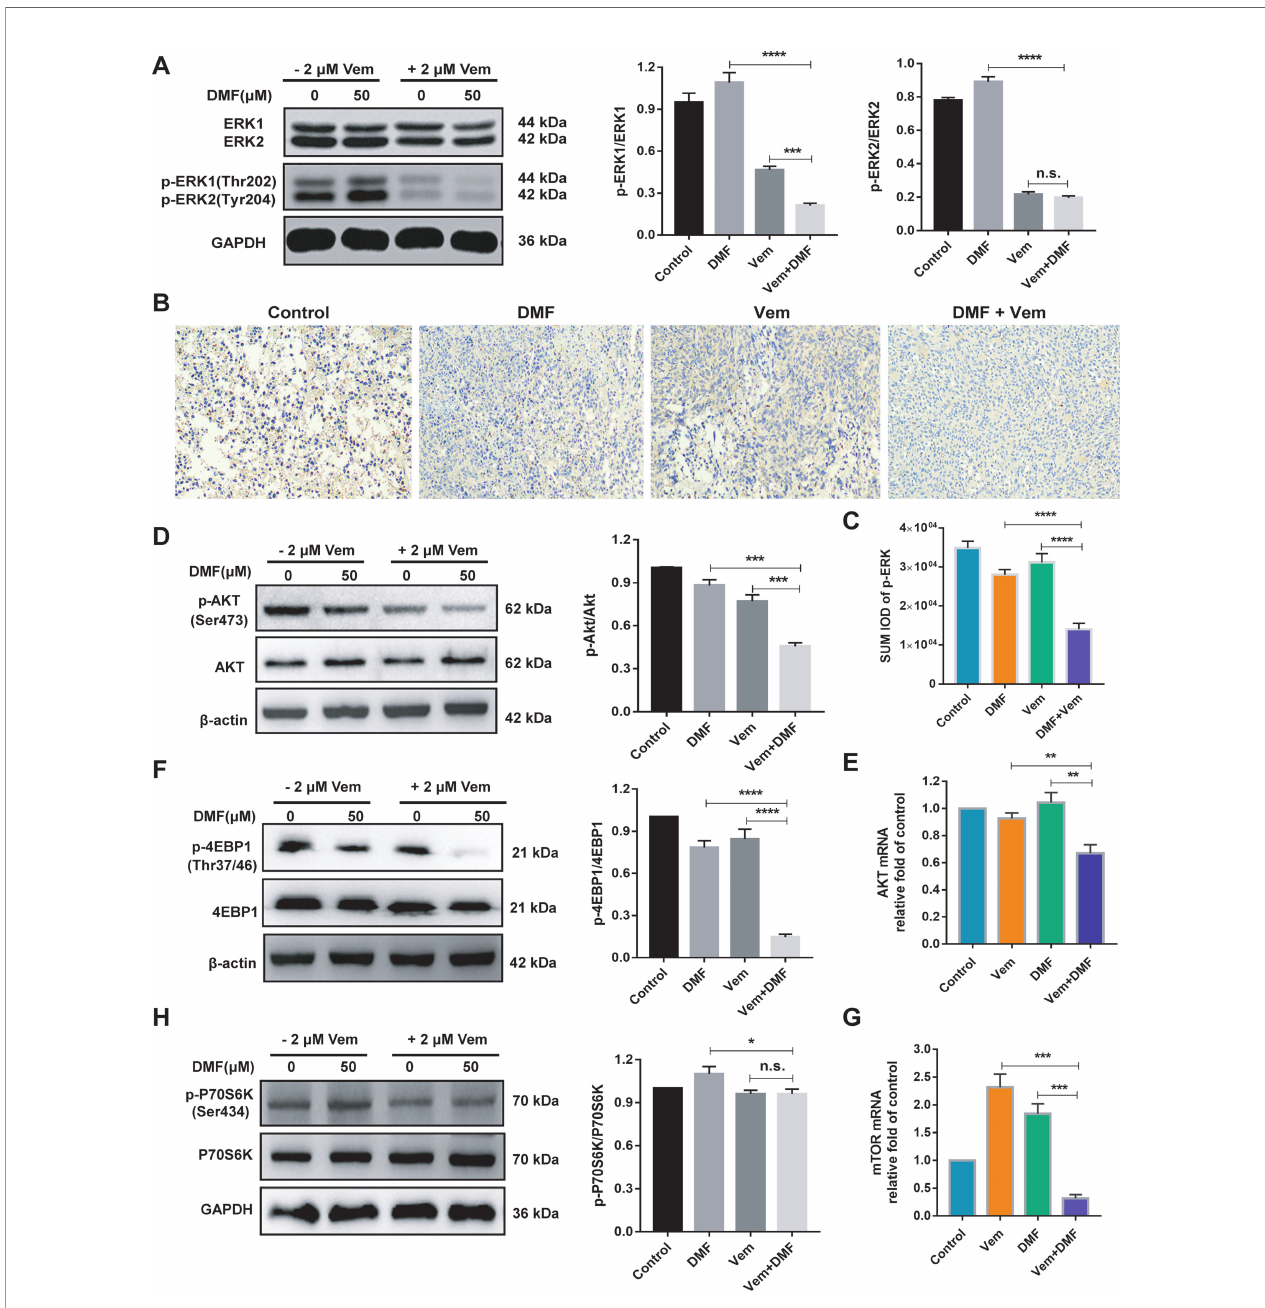
FIGURE 6 | Effects of DMF/Vem treatment on MAPK and AKT/mTOR pathways related proteins in melanoma cells. (A) Western blot analysis of total and phosphorylated ERK1/2 in A375 cells treated with 50 m M of DMF and/or 2 m M of Vem for 48 h, with GAPDH as loading control. (B) Representative images of p-ERK immunohistochemical staining in tumor tissue. All images were taken at 10× magni fi cation. (C) The integrated optical density (IOD) of immunohistochemical results of p-ERK was calculated by Image Pro Plus 6.0. **** P < 0.0001, using one-way ANOVA to compare the differences between the groups. (D) Western blot analysis of total and phosphorylated AKT in A375 cells treated with 50 m M of DMF and/or 2 m M of Vem for 48 h. (E) qPCR analysis of AKT1 mRNA levels in A375 cells following treatments with 50 m M of DMF and/or 2 m M of Vem for 24 h, with 18S as reference control. (F) Western blot analysis of total and phosphorylated 4EBP1 in A375 cells treated with 50 m M of DMF and/or 2 m M of Vem for 48 h, with GAPDH as loading control. (G) qPCR analysis of mTOR mRNA levels in A375 cells treated with 50 m M of DMF and/or 2 m M of Vem for 24 h, with 18S as reference control. (H) Western blot analysis of total and phosphorylated P70S6K in A375 cells treated with 50 m M of DMF and/or 2 m M of Vem for 48 h, with GAPDH as loading control. Protein expression in western blot was determined by densitometry (gray value) calculations with Image J software. All numerical data were shown as mean ± SD (n=3), * P < 0.05, ** P < 0.01, *** P < 0.001, **** P < 0.0001 vs. DMF or Vem treatment, n.s., not signi fi cant, using one-way ANOVA to compare the differences between the